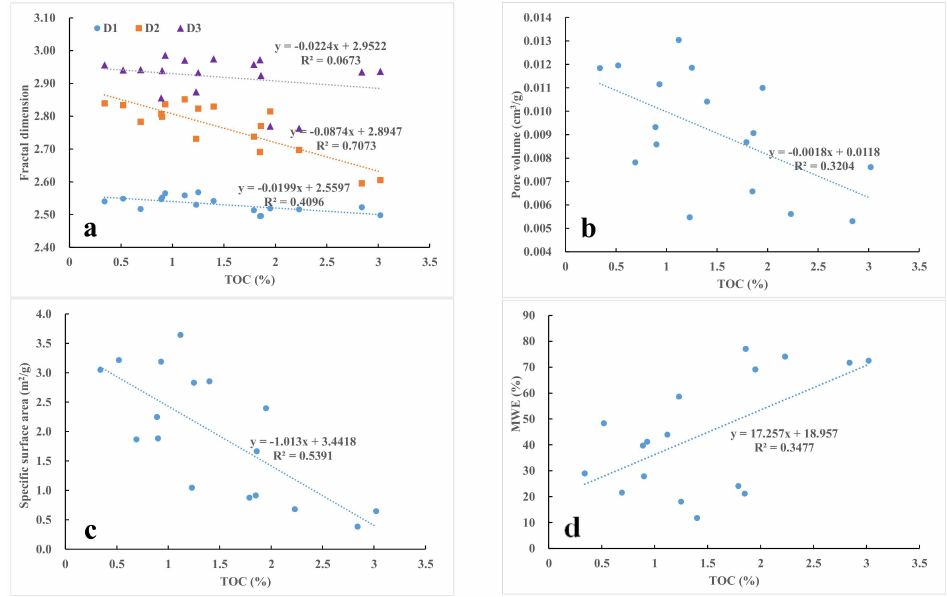
Figure 11. Impact of TOC on fractal dimension ( a )and pore structure parameters ( b – d ).